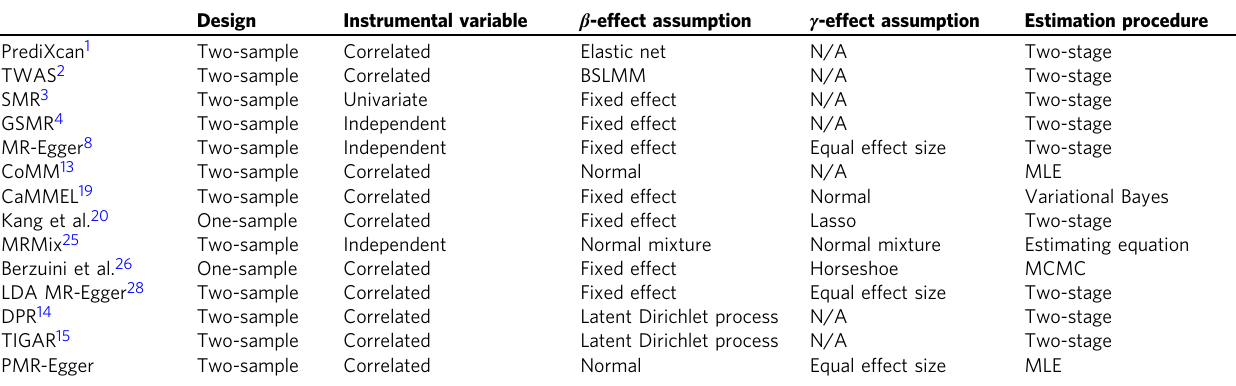
Table 1 Summary of some existing MR